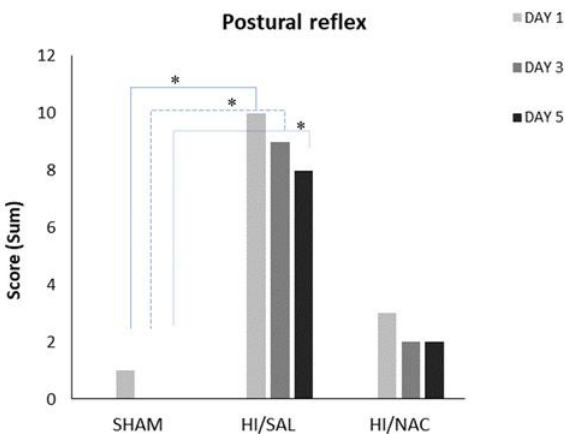
Figure 2. Performance of SHAM, HI/SAL and HI/NAC groups during the 3 days of examination. (*) p < 0.05 HI/SAL vs. SHAM